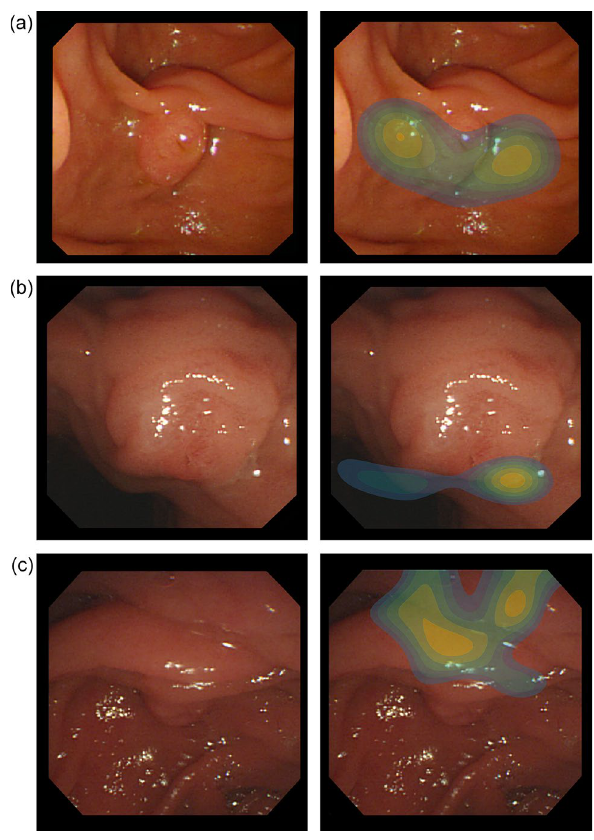
Figure 4. Grad-CAM results of the cannulation difficulty prediction model for accurately predicted examples. The heatmap visualizations are the outputs of Grad-CAM for the written GT label. They show where the model focused attention to estimate the cannulation difficulty. The lighter the color, the stronger is the attention required. The results show that the model sees distinct features of each